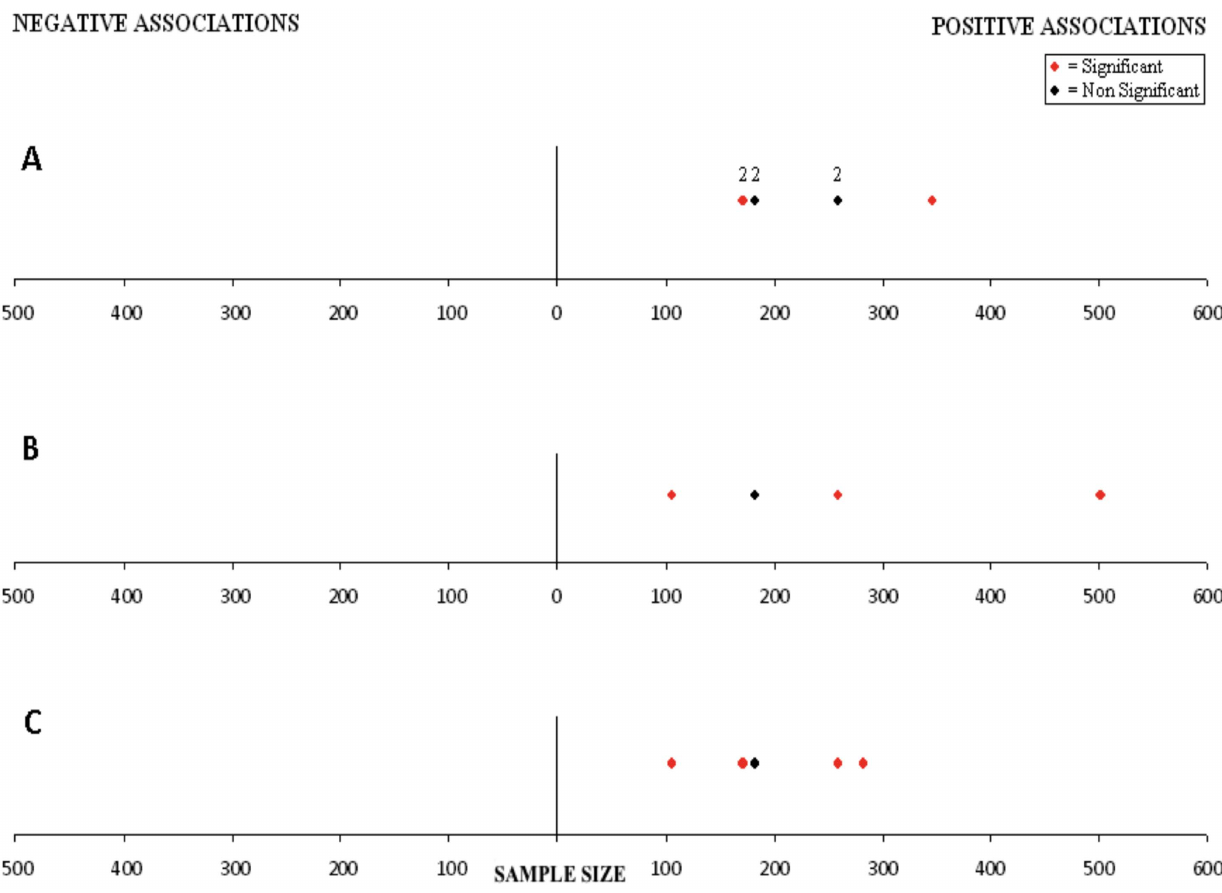
Figure 2. Associations between socioeconomic measures and event-free and overall survival in low- and middle-income countries. A. Measures of material possession, family composition, insurance status, immigrant status, and health care accessibility. B. Measures of education and occupation. C. Measures of income. Positive=lower socioeconomic status associated with inferior outcome; Negative=lower socioeconomic status associated with superior outcome. Magnitudes of association are not plotted. Statistically significance is denoted in red. Data points with a number above represent multiple socioeconomic variables.